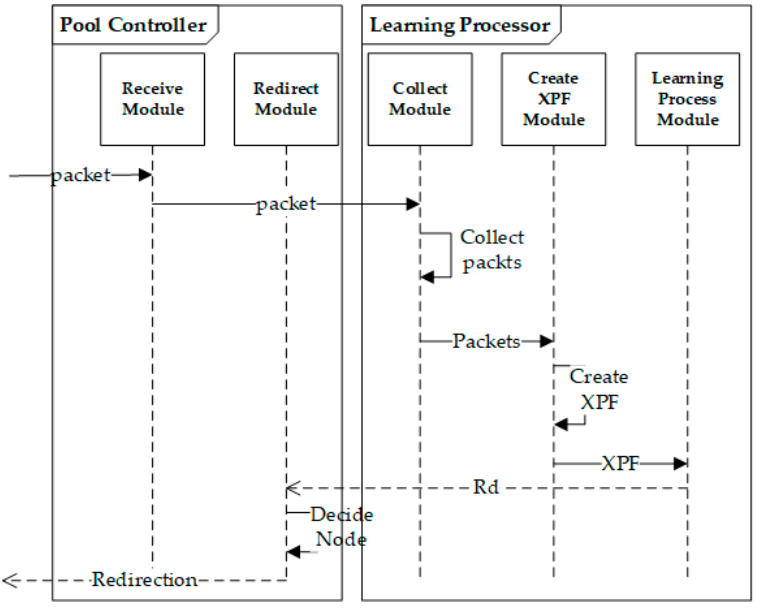
Figure 2. Learning software flowchart.